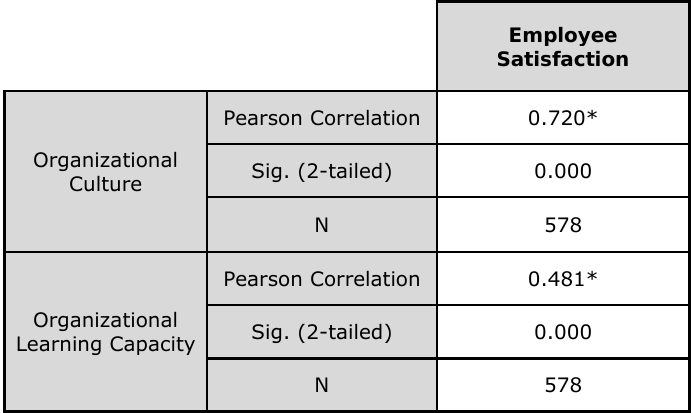
Table 4. “Correlation